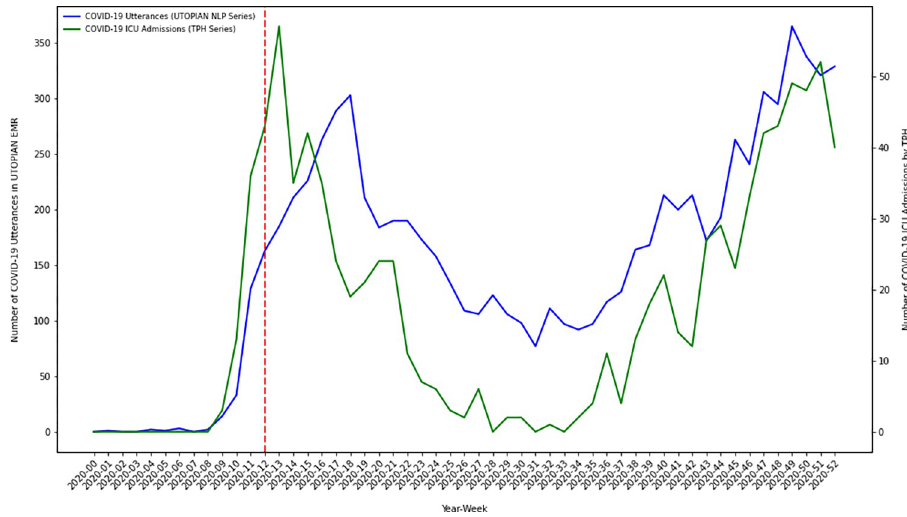
Fig 3. Time series plot of the composite count of the number of COVID-19 positive utterances from each of the three electronic medical record text streams (lab text, health condition diagnosis text and clinical notes) versus the number of COVID-19 related ICU admissions in Toronto, Canada (data extracted from Toronto Public Health).